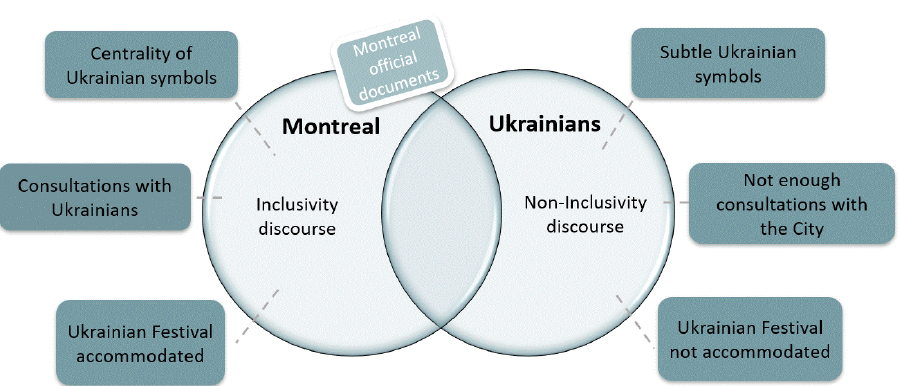
Fig. 4. Divergent discourses between the City of Montreal and the Ukrainian community of